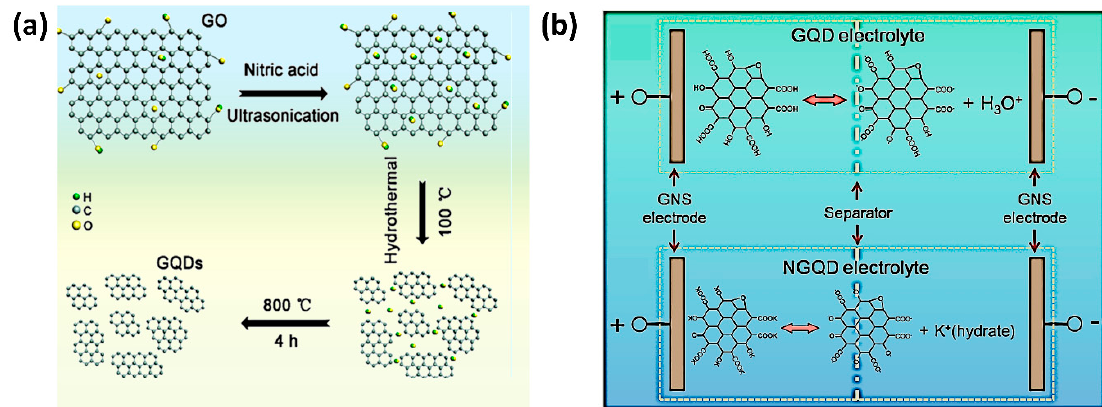
Figure 6. ( a ) Schematic of synthesis of GQDs with uniform size for an SC device: reproduced from Reference [119]. Copyright American Chemical Society, 2018. ( b ) Schematic Illustration of GQDs and an N-GQD solution as the electrolyte in EDLC supercapacitors: reproduced from Reference [120]. Copyright Springer Nature, 2016.